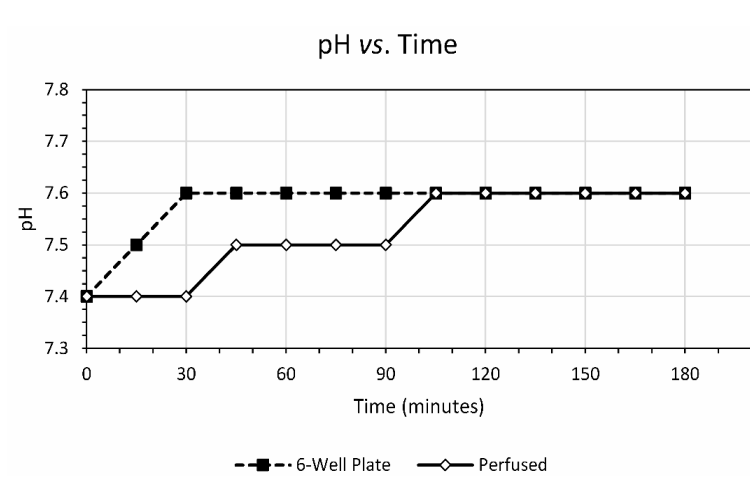
Figure 4. Line graph showing pH over